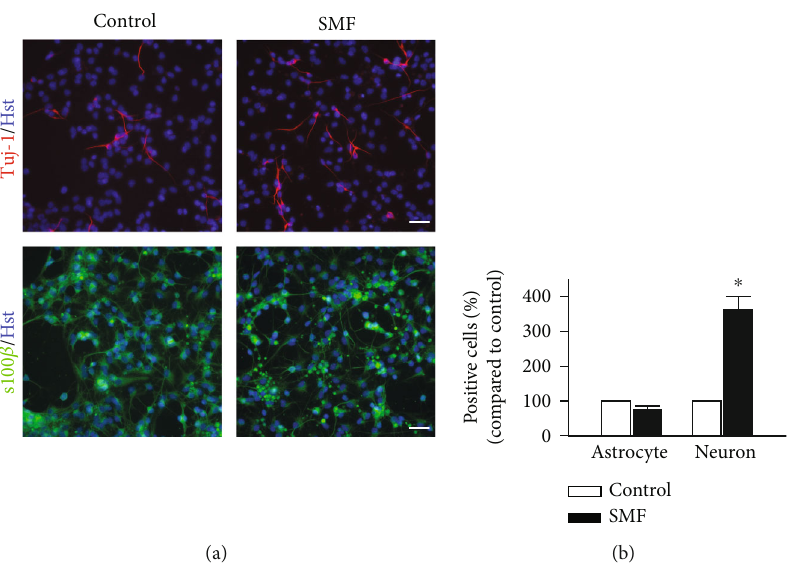
Figure 4: SMF exposure promotes fate determination toward neuronal lineages and neuronal maturation of mNPCs. (a) The mNPC-derived cells were stained with an antibody for Tuj-1 (red), s100 β (green), and Hoechst 33342 (Hst, blue). The immunostaining images showed that the percentage of Tuj-1-positive cells was signi fi cantly increased after SMF stimulation. Scale bar, 25 μ m. (b) Summary of the change of s100 β - and Tuj-1-positive cells in cultures that treated/untreated with SMF. ∗∗ p < 0 : 05 compared with control groups (Student ’ s unpaired t